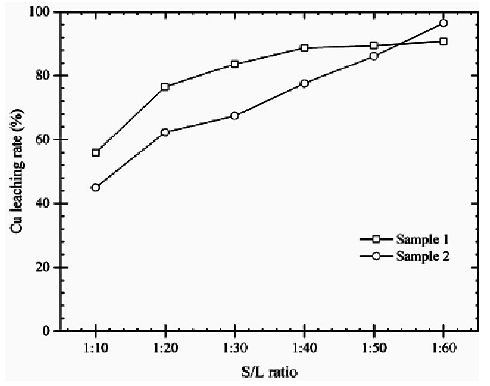
Fig. 1. Effect of leaching time on copper